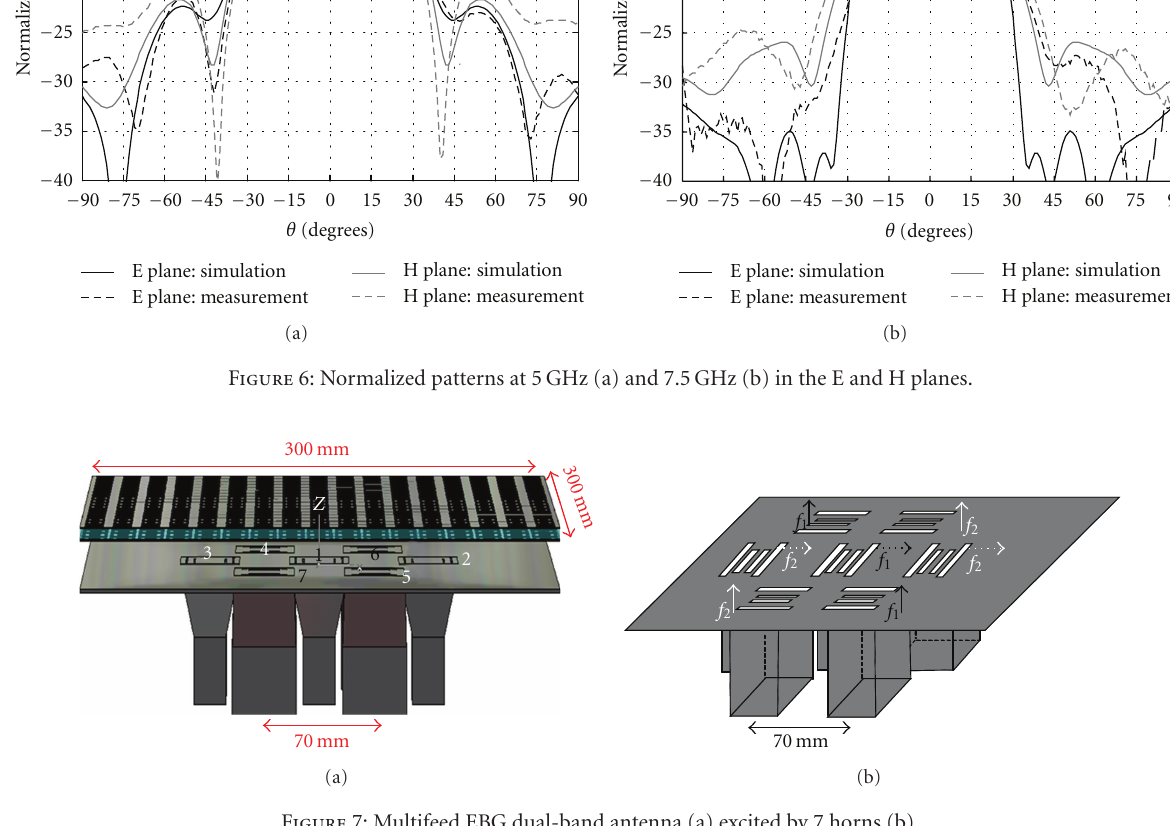
Figure 7: Multifeed EBG dual-band antenna (a) excited by 7 horns (b).